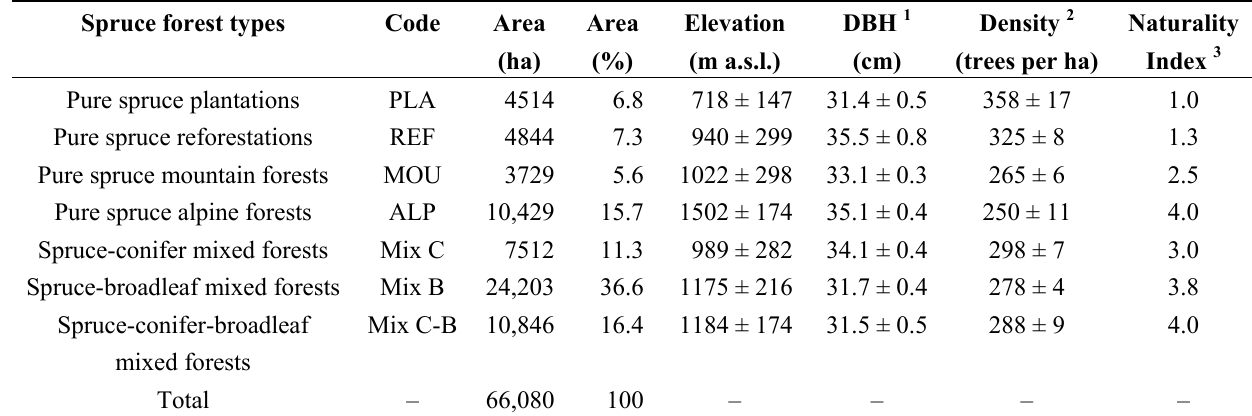
Table 1. Main types of spruce forests occurring in the investigated area and their characteristics. The values of dendrometric parameters are reported as mean ± standard